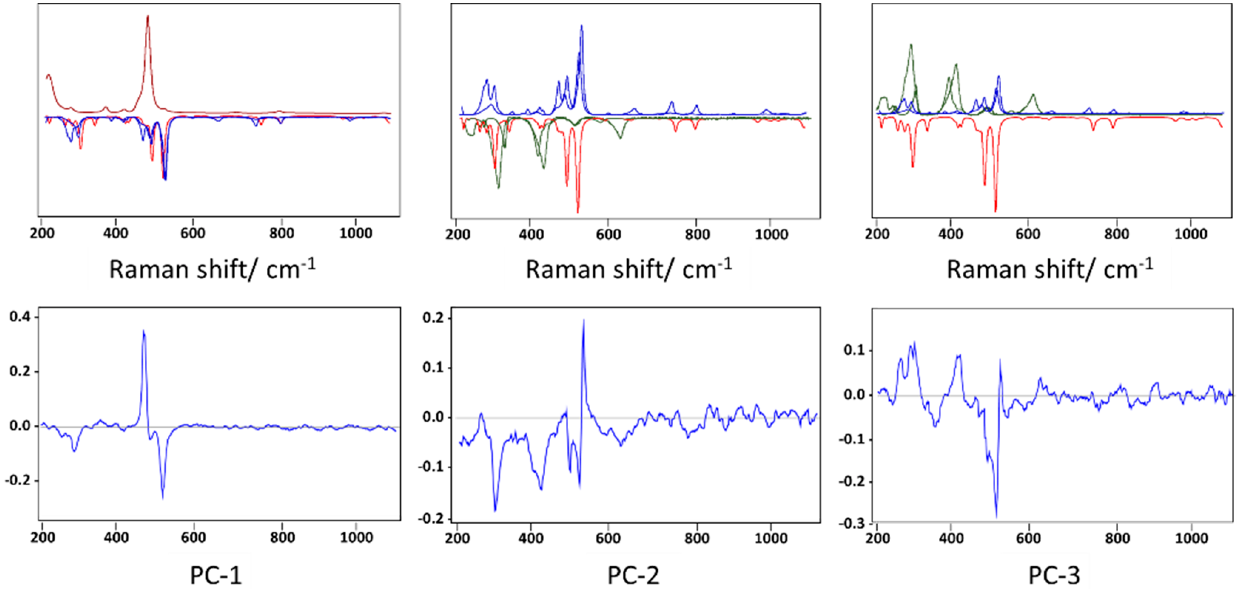
Figure 9. PCA loadings resulting from the analysis of the Raman spectra of the shell section of the studied fulgurite ( bottom ) as compared with the Raman spectra of the relevant minerals ( top ). The colors of the spectra of the minerals are the same as those shown in Figure 7.